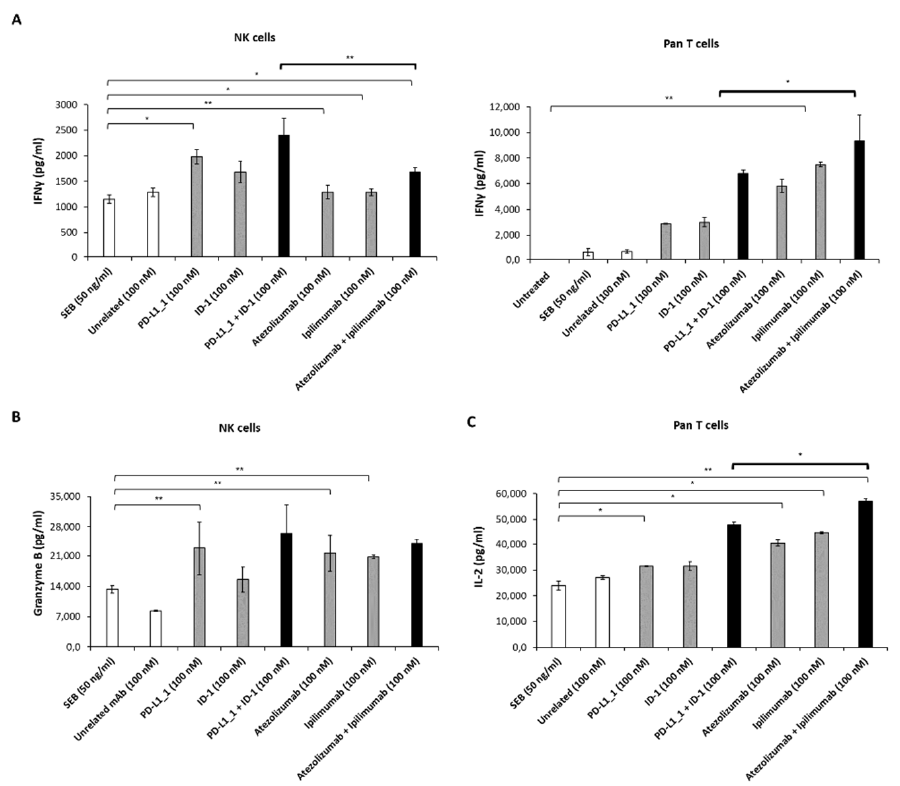
Figure 2. Effects of novel mAbs on the activation of stimulated lymphocytes. NK- and Pan T-enriched populations were treated with SEB for 66 h, in the absence (white bars) or in the presence of the anti-PD-L1 (PD-L1_1 or atezolizumab) or the anti-CTLA-4 (ID-1 or ipilimumab) mAbs, used as single agents (light grey bars) or in combination (black bars). The levels of IFN γ ( A ), Granzyme B ( B ) and IL-2 ( C ) were measured by ELISA assays (performed as described in Materials and Methods). Cells untreated or treated with an unrelated mAb were used as negative controls. Values were reported as the mean of at least three determinations obtained in three independent experiments. Error bars depict means ± SD. P-values were calculated by comparing each treatment with untreated co-cultured cells or comparing the two combinations with each other and reported as ** p < 0.01; * p < 0.05.